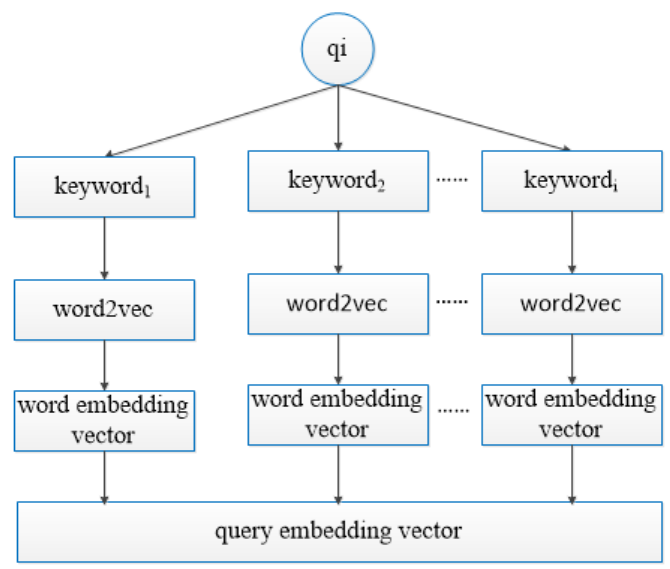
Figure 2. The process of calculating query